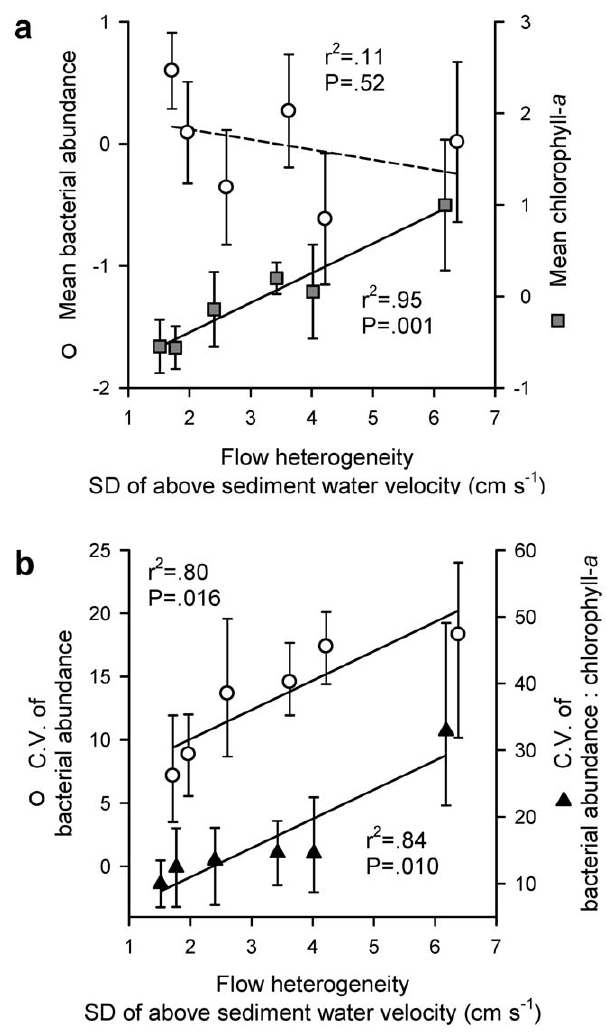
Figure 2. Microbial biofilm biomass. ( a ) Flow heterogeneity (SD Rxyz ) versus mean z-standardised bacterial abundance and chloro- phyll- a (error bars represent 95% confidence intervals, sample size n=12 per flume); and ( b ) flow heterogeneity versus the average coefficient of variation of bacterial abundance and the bacterial abundance to chlorophyll- a ratio (error bars represent 95% confidence intervals generated by bootstrapping, sample size n=4 per flume, see Methods).